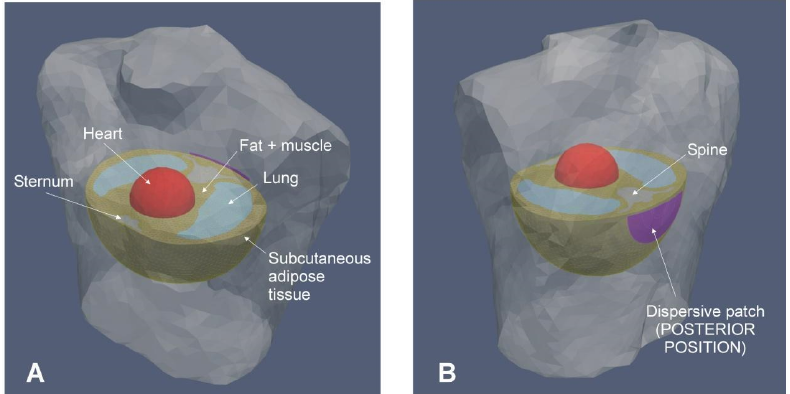
Figure 2. ( A ) CT-scan slice from a representative patient. ( B ) Computer model (units in mm) of posterior RFCA inspired by the CT-scan image and including the most representative organs. ( C ) Zoom of the RF catheter and cardiac wall.